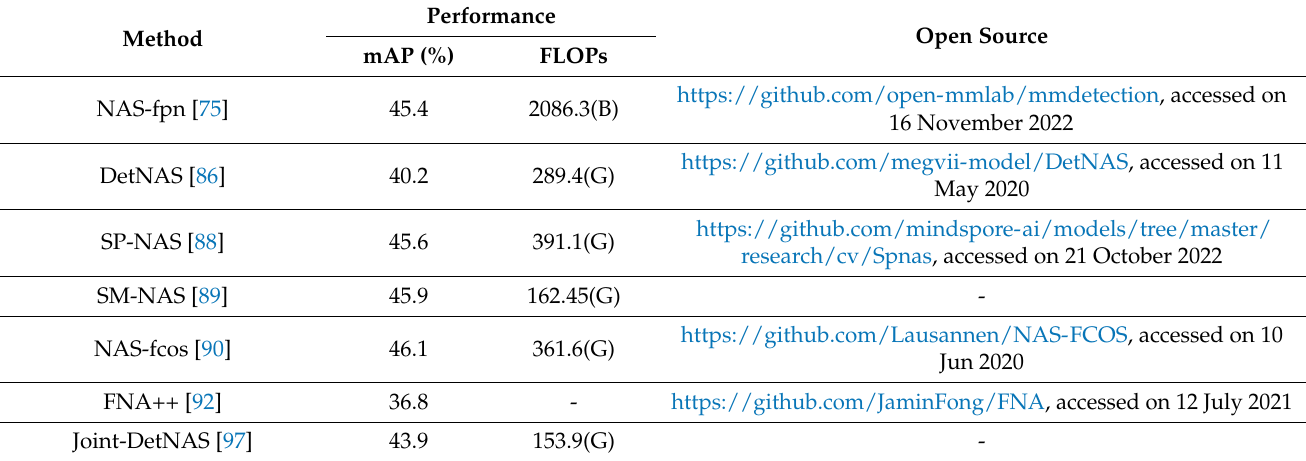
Table 2. State-of-the-art comparison on MS COCO test-dev for bounding box object